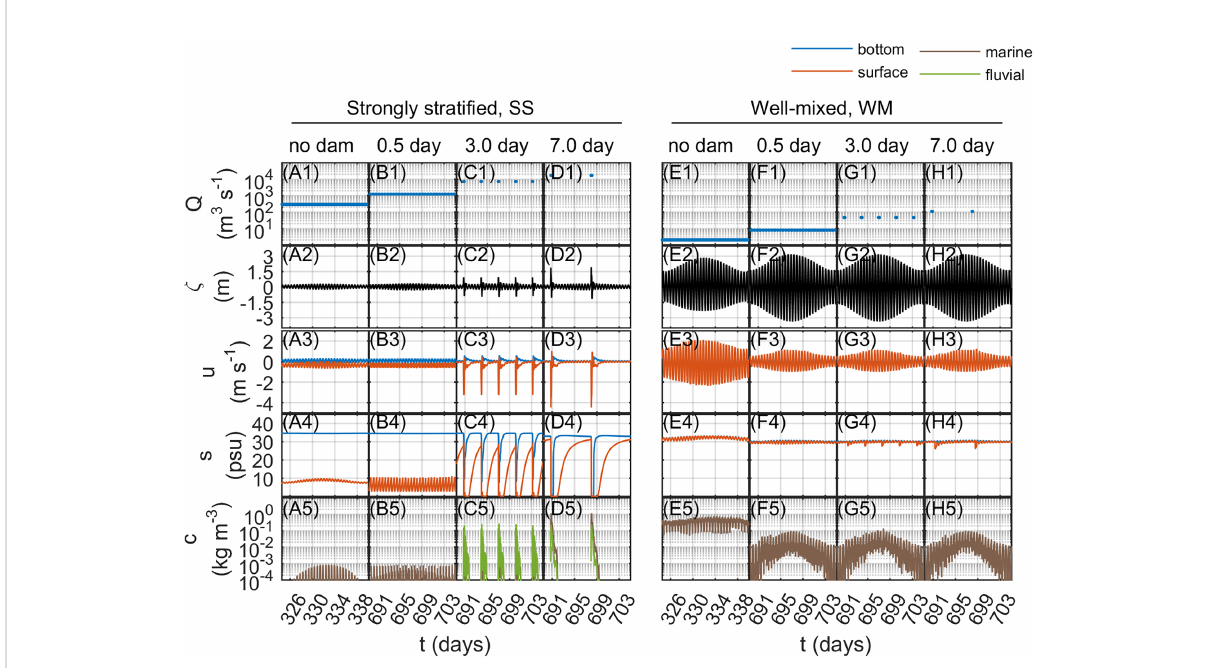
FIGURE 6 Representative time series comparing strongly strati fi ed and well-mixed estuaries under different discharge intervals. (A1-H1) Freshwaterdischarge ( Q , m 3 s -1 ), (A2-H2) sea surfaceelevation ( z , m), (A3-H3) bottom and surfacealong-channel current velocity ( u , m s -1 ); (A4-H4) bottomand surfacesalinity ( s , psu),and (A5-H5) suspended sediment concentration( c , kg m -3 ) versus time( t , days). Data arefromthe center ofthe regionofinterest (ROI) for cases with an estuarine dam at x = 20 km. Time is day sinceinitializationwith estuarine dam placed onday 365.Positive velocity